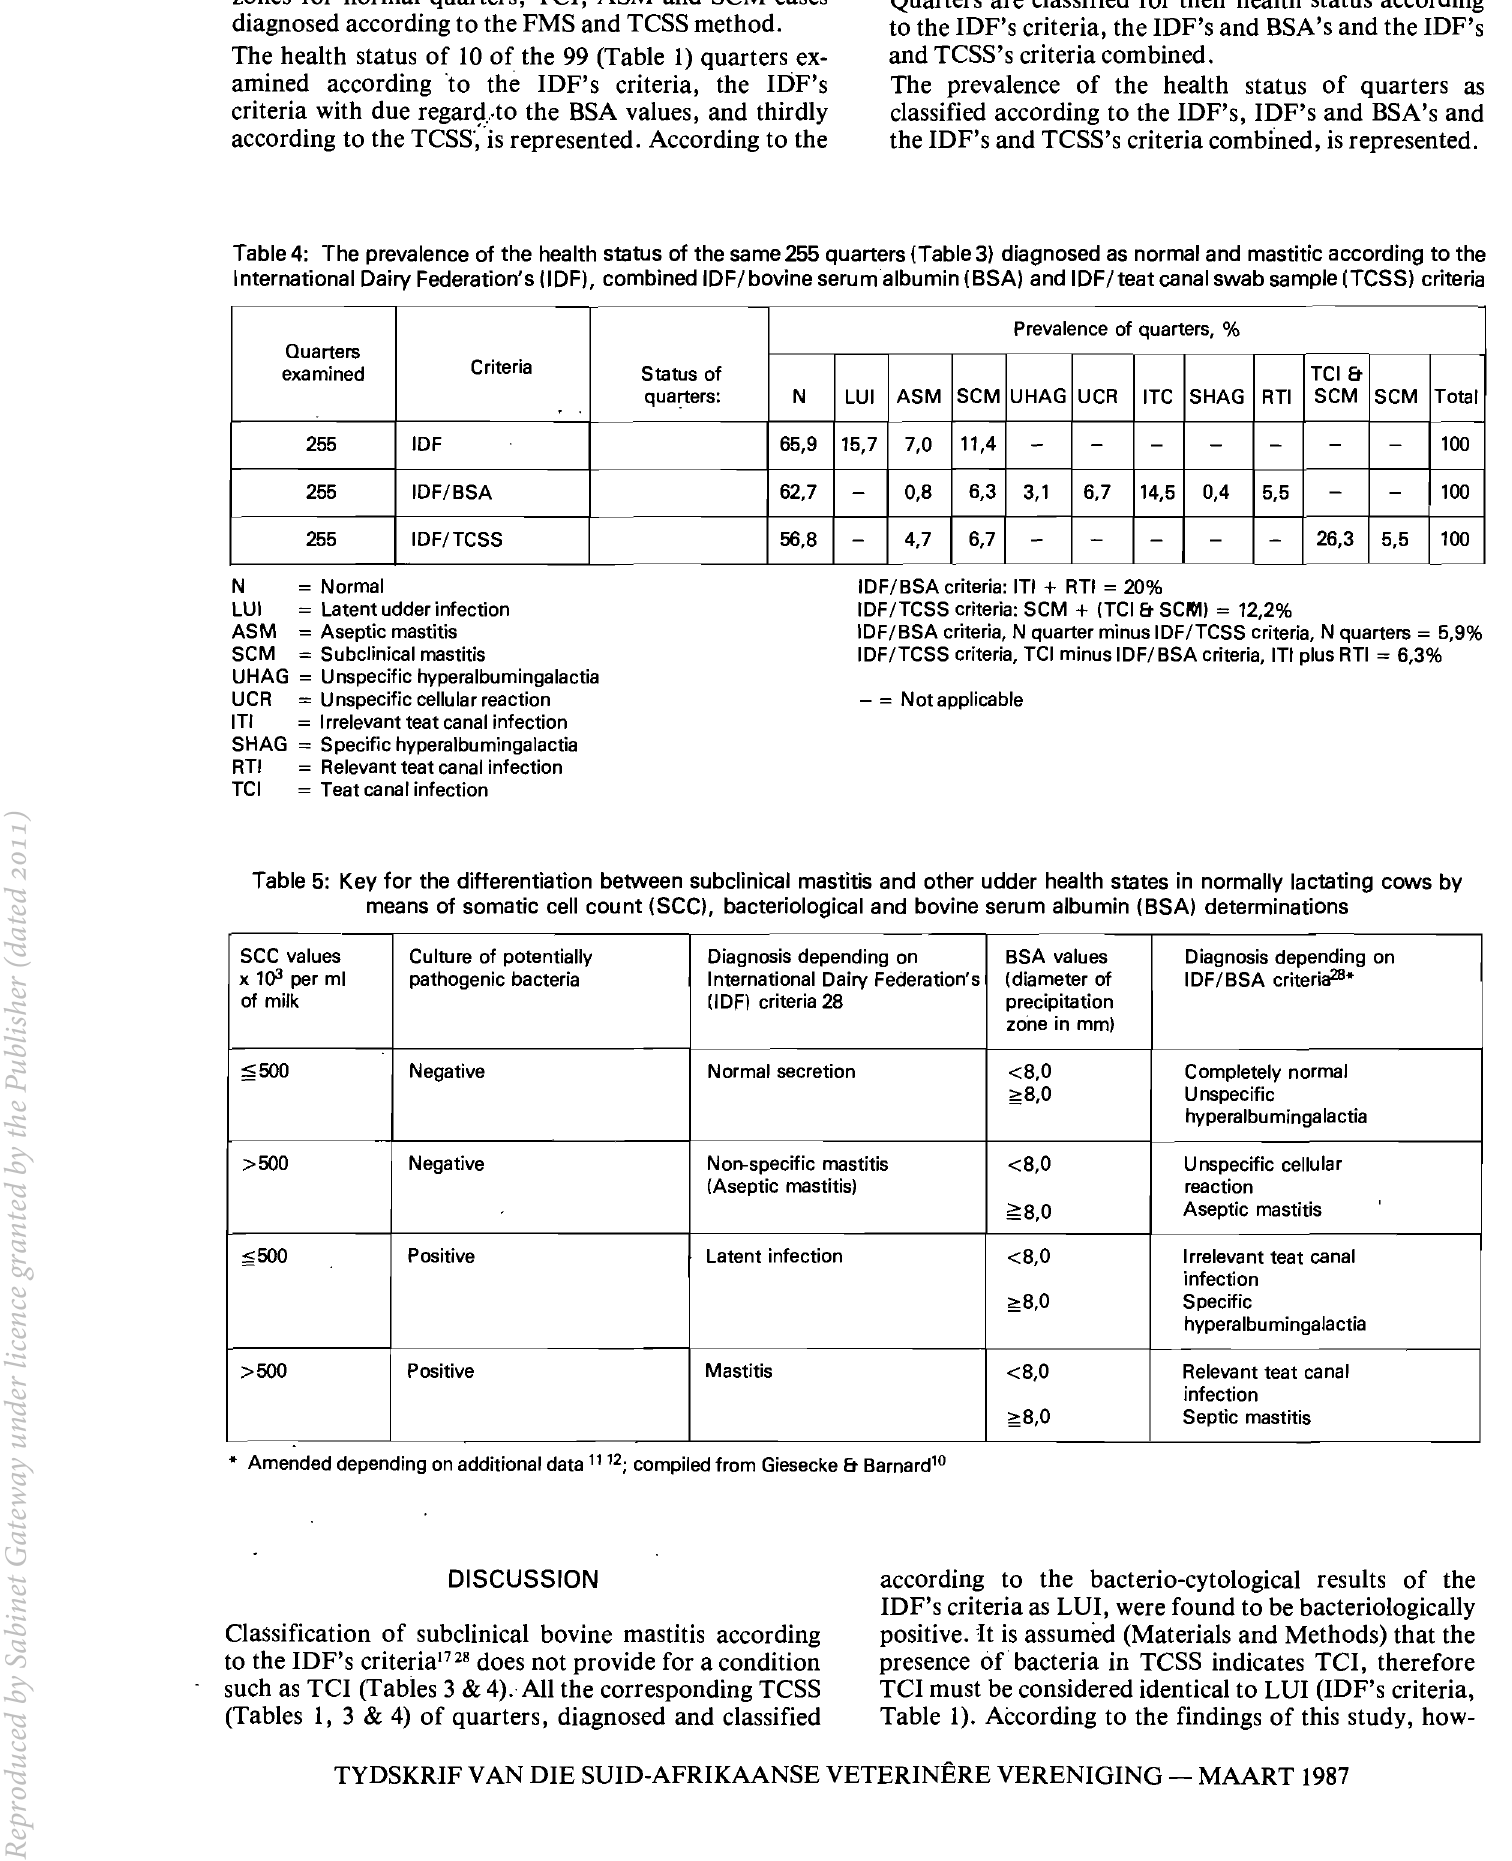
Table 4: The prevalence of the health status of the same 255 quarters (Table 3) diagnosed as normal and mastitic according to the International Dairy Federation's (lDFl, combined IDF/bovine serum albumin (BSA) and IDF/teat canal swab sample (TeSS) criteria